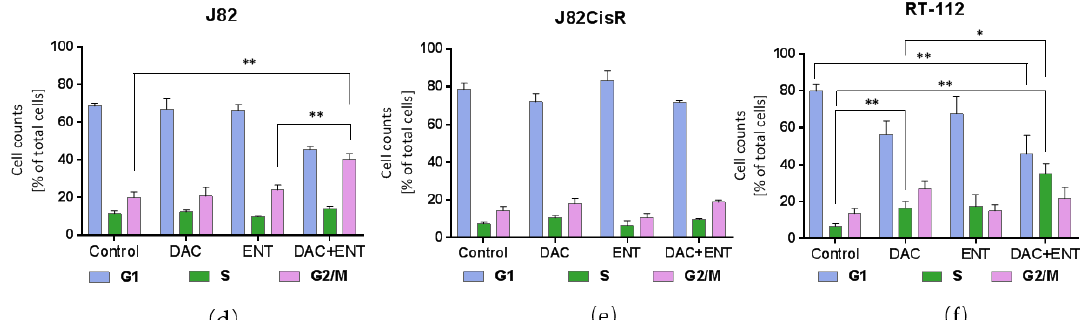
Figure 4. Effect of combination of DAC and ENT on cell cycle progression in J82, J82CisR, and RT-112 cell lines. Cells were incubated with DAC (1 µM in J82 and J82CisR, 0.1 µM in RT-112) or ENT (3.16 µM in J82 and J82CisR, 2 µM in RT-112) or with a combination of DAC and ENT. DMSO was used as a solvent control. RN1, RN2, RN3, and RN4 indicate the cell cycle phases of sub-G1, G1, S, and G2M, respectively. ( a ) Combination treatment led to cell cycle arrest at G2/M phase in J82 cell line. ( b ) Cell cycle distribution of J82CisR cells was not affected by either drug treatment alone or in combination. ( c ) Combination treatment induced cell cycle arrest in S phase in RT-112 cell line. ( d – f ) Quantification of the cell cycle distribution after the drug treatments in J82, J82CisR, and RT-112 cell lines. Data shown are the mean ± SD of at least three independent experiments. ** p < 0.01, * p < 0.05 by t -test.